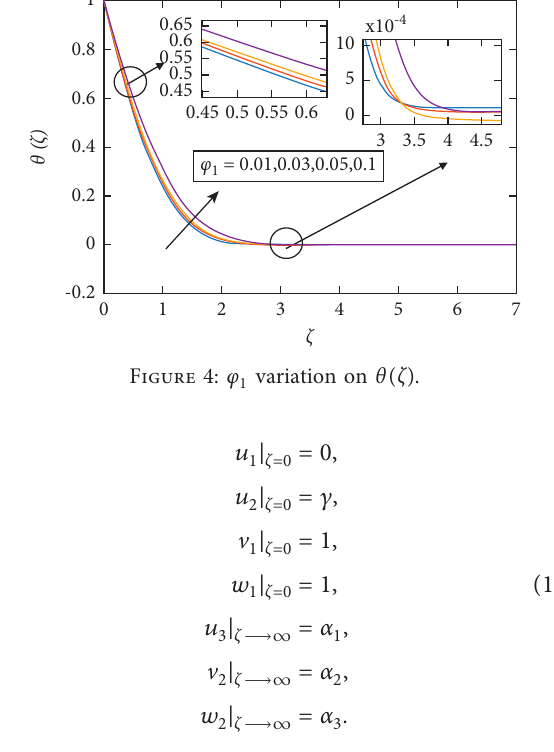
variation on f ′ ( ζ ) . 2